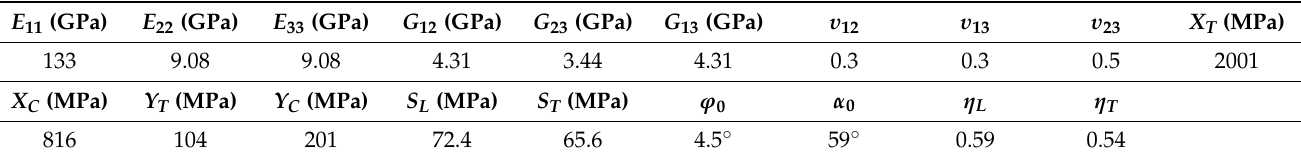
Table 2. The material parameters of PEEK/AS4.